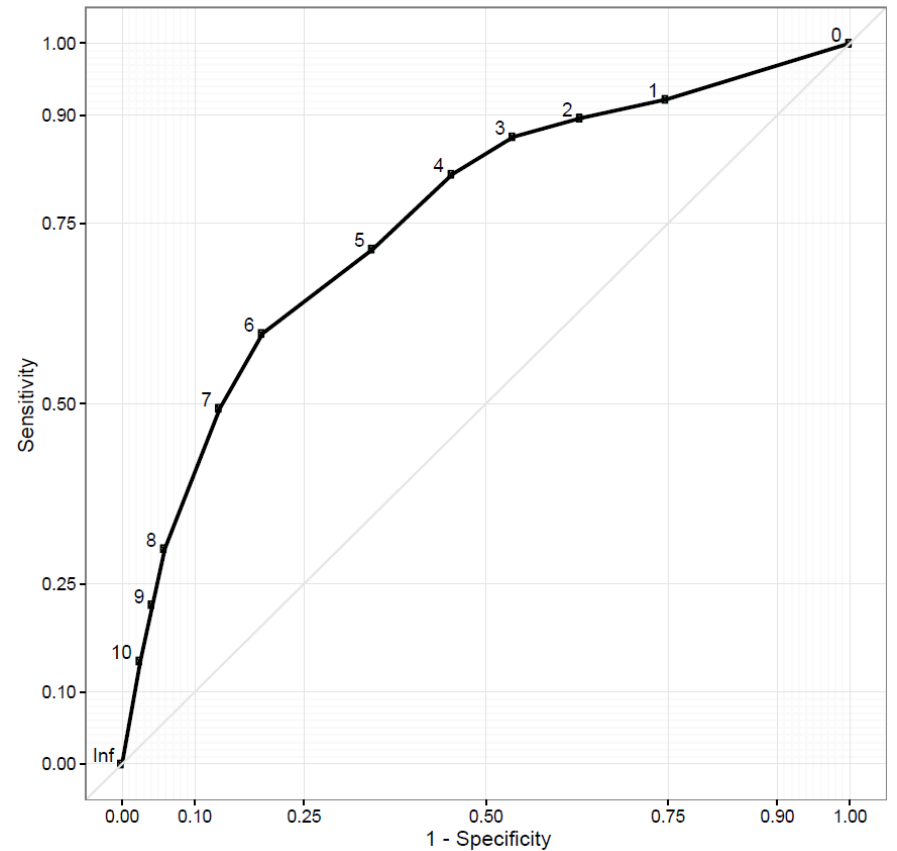
Figure 3. Receiver operator characteristics curve for distress thermometer detecting depression/anx- iety.